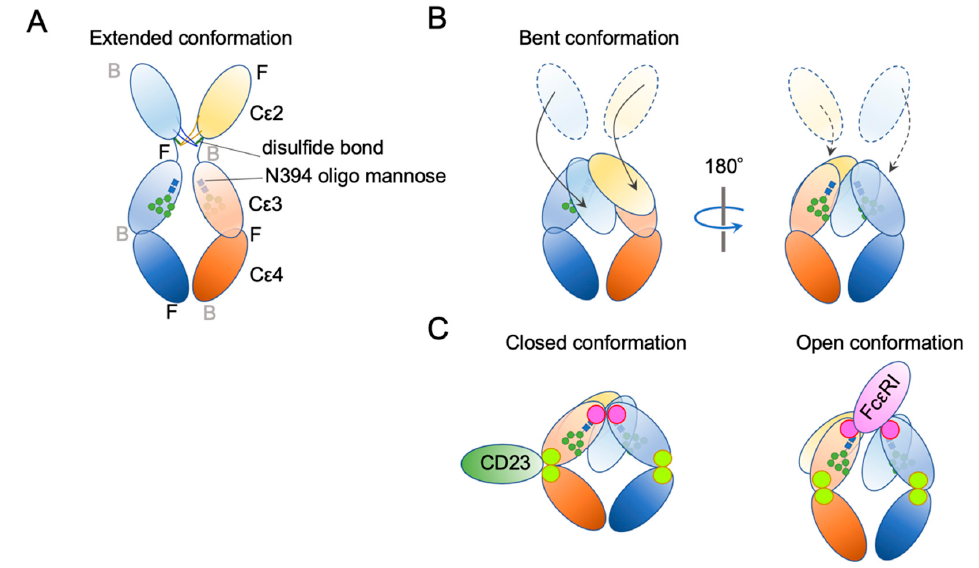
Figure 4. Schematic representation of two major conformational concepts. ( A ) An extended conformation of IgE-Fc. The front–back coordination is also described. ( B ) The bent conformation. ( C ) The concept of “closed” and “open”